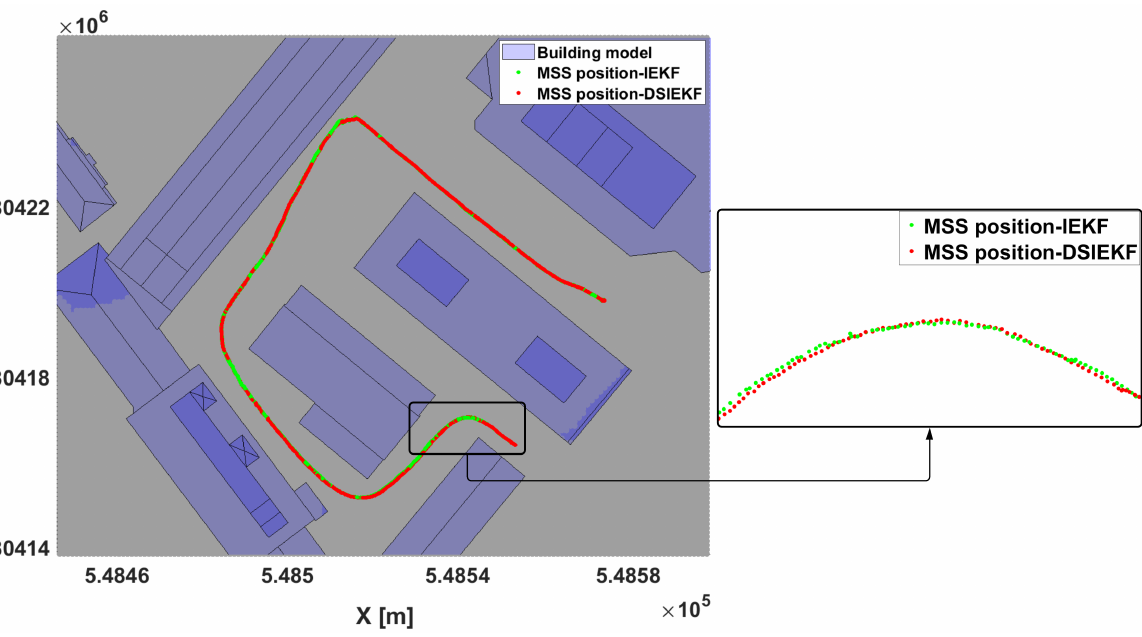
Figure 10. The estimated trajectories in 2D (top